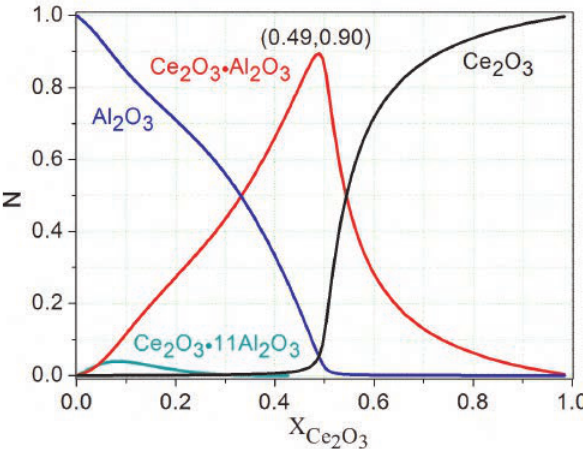
Fig. 1: The relationship between N i in Ce 2 O 3 -Al 2 O 3 slag and the mole fraction of Ce O at 1873 K 2 3